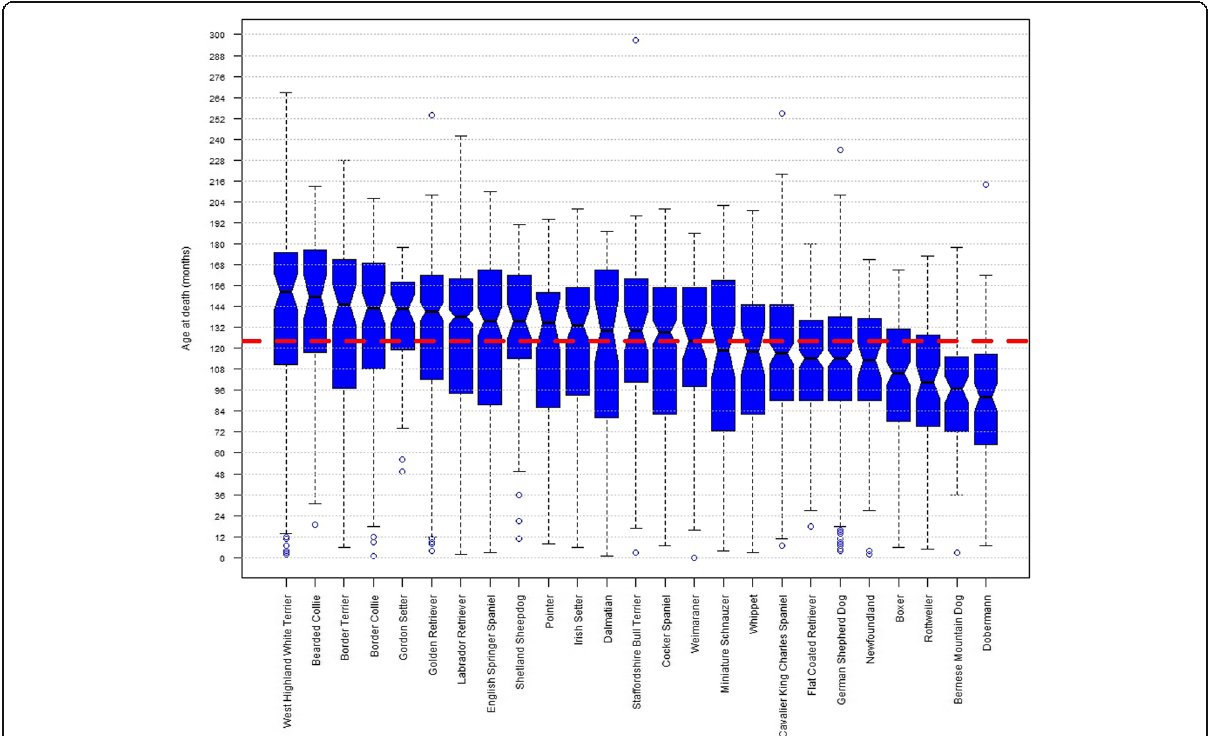
Fig. 2 Box and Whisker plot of age at death across breeds. Notched Box and Whisker plot of age at death (months) across breeds, for the 25 breeds with ≥ 50 deaths reported. ‘ Notches ’ in the boxes indicate the approximate 95% confidence interval of the median. The red dashed line indicates the median age at death of all dogs in the survey (n = 5663) of 124 months, and the thickness of this line approximates to the 95% confidence interval (122.57 to 125.43